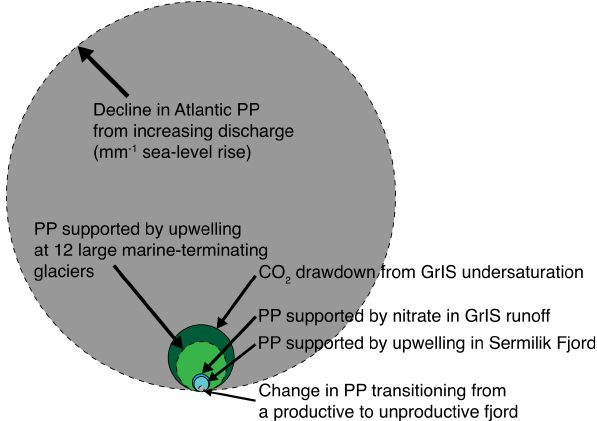
Figure 10. A scale comparison of the significance of different chemical/physical processes driven by glacial discharge in terms of the resulting effects on annual marine primary production (PP) or CO 2 drawdown (units TgCyr − 1 ) . Bold lines indicate mean esti- mates based on multiple independent studies; dashed lines are based on only one. Green–blue colours are positive; grey colours are neg- ative. Calculated changes (largest–smallest) are determined from glacial discharge superimposed on a modelled global RCP8.5 sce- nario (Kwiatkowski et al., 2019), p CO 2 uptake due to meltwater- induced undersaturation scaled to the Greenland Ice Sheet (Meire et al., 2015), computed upwelled NO 3 fluxes (assuming 100% utiliza- tion at Redfield ratio, Hopwood et al., 2018), mean freshwater NO 3 (Greenland) inventory (Table 3), NO 3 anomaly due to upwelling in Sermilik Fjord (Cape et al., 2019), and contrasting the mean PP for groups II and IV (Table 1) for a fjord the size of Young